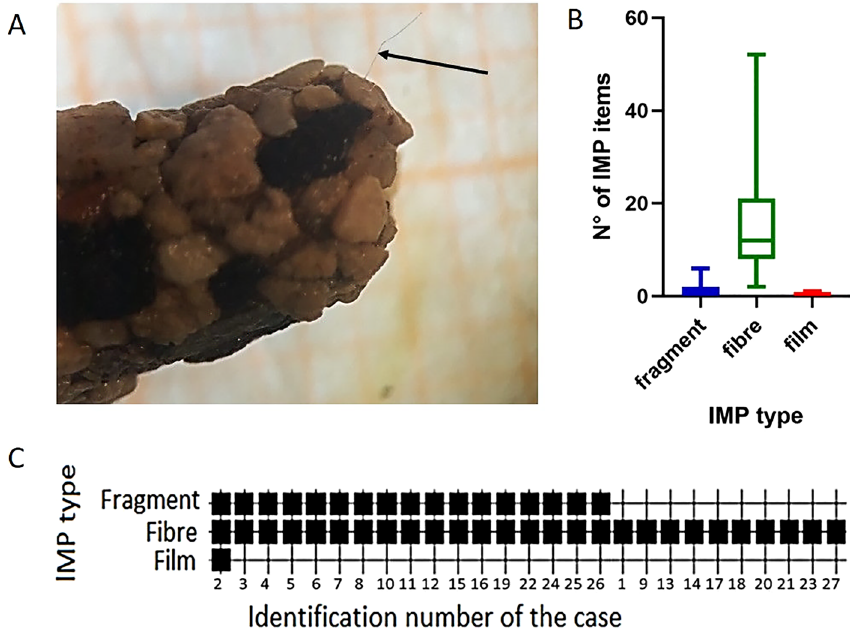
Figure 2. Description of the large microplastics (lMP) found in the caddisfly natural cases. ( A ) The arrow highlights a lMP fibre included in caddisfly natural case. ( B ) Abundance of lMP found in the natural cases of caddisflies. Bars indicate 1–99 percentile. The three groups are significantly different ( p < 0.01, Kruskal Wallis). ( C ) Black squares on the grid indicate the presence of lMP divided per shape (fragment, fibre, film) in each natural case of caddisflies. The image ( A ) is obtained by the software PowerPoint (ver. 2002, https ://www.micro soft.com/it-it/micro soft-365/power point ); ( B ) by the software GraphPad Prism (ver. 8.4.2, https ://www.graph pad.com/suppo rt/faq/prism -842-relea se-notes /), ( C ) by the software PAST (ver. 3.14, http://folk.uio.no/ohamm er/ past/) 61